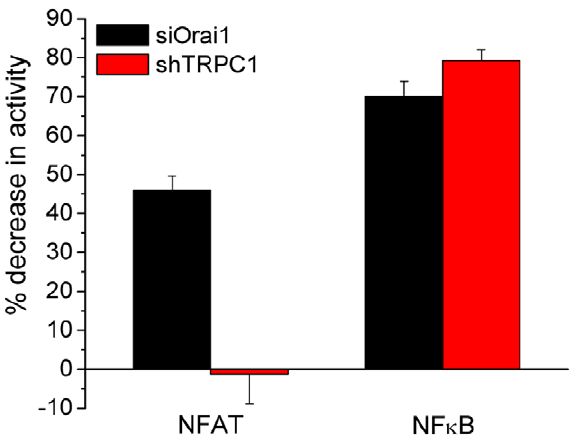
Figure 7. Contribution of Orai1 and TRPC1 channels to the activation NFAT- and NF k B-driven luciferase activities. Lucifer- ase activities driven by NFAT and NF k B following stimulation with CCh (100 m M) or PMA + CCh (10 ng/ml and 100 m M, respectively) in cells transfected with siOrai1 or shTRPC1. Histogram shows % decrease in CCh-stimulated luciferase activities in shTRPC1- or siOrai1-treated cells (relative to that in mock-transfected control cells). Data were obtained in at least 3 separate experiments for each transcription